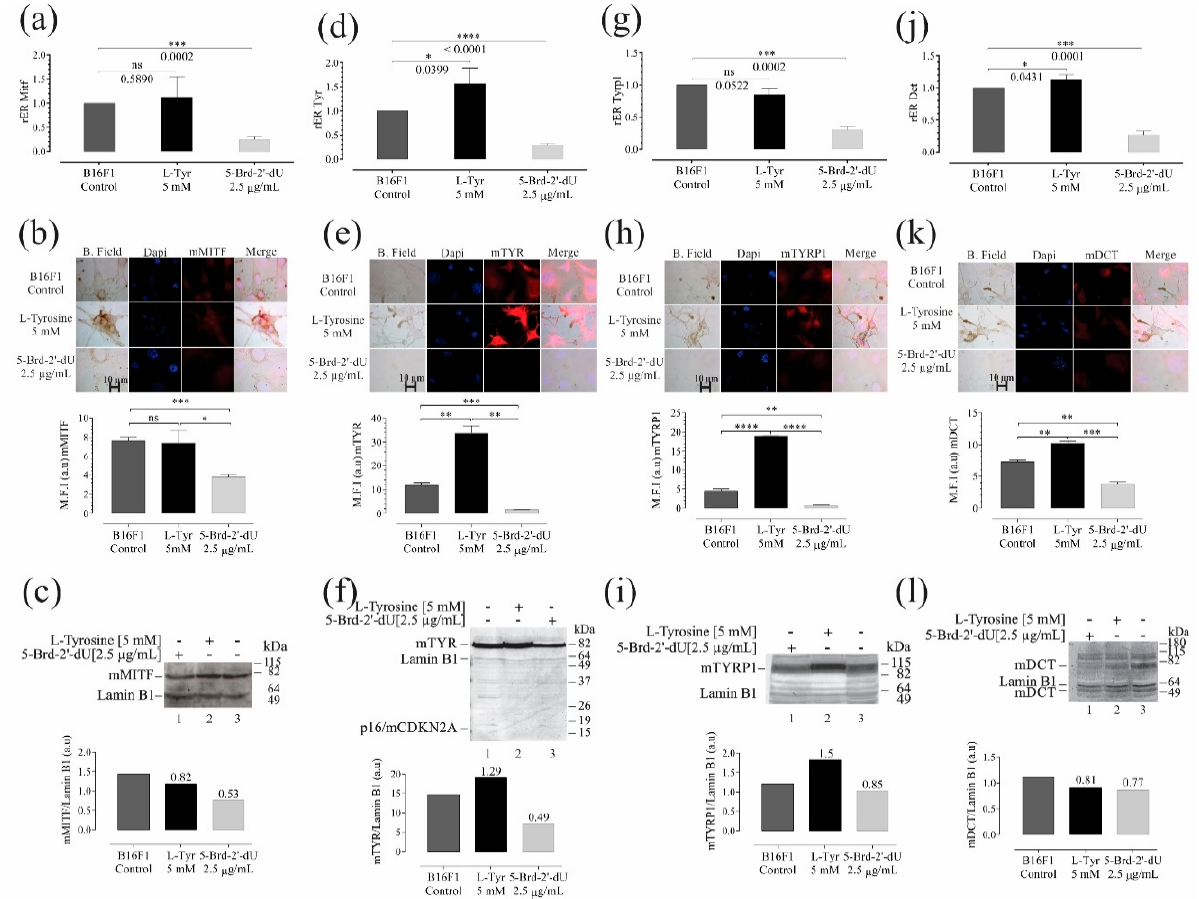
Figure 6. Variations in the expression of genes and their protein products are associated with melanogenesis in B16F1 cells induced at differential pigmentation and a decrease in proliferation. Relative expression radius (rER) by RT-qPCR, n = 4, representative photographs of the location and distribution by immunofluorescence (red) in nuclear counterstain with DAPI (blue), quantification of expression by mean fluorescence intensity (MFI), and western blot for the master regulator of melanocyte cell differentiation—MITF ( a – c ), and the enzymes Tyr ( d – f ), Trp1 ( g – i ), and Dct ( j – l ). The level of significance (*) using two-tailed multiple t -tests. The differences were considered statistically significant for a p -value < 0.05, ns: not significant. Significant (*) with p < 0.05, very significant (**) with p < 0.01, highly significant (***) with p < 0.001 and very highly significant (****) with p <